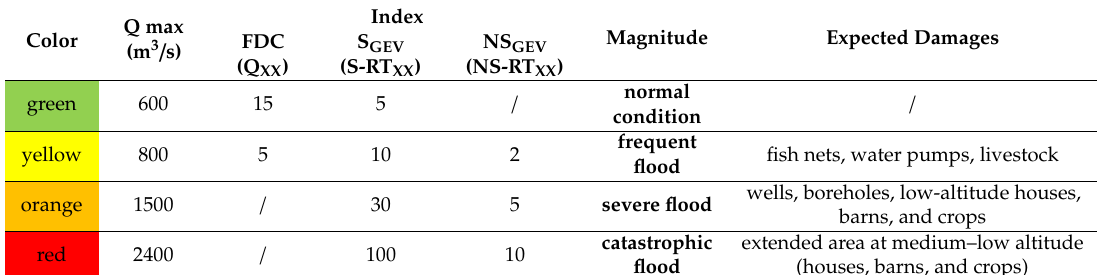
Table 5. Hazard thresholds for the di ff erent flow conditions of the Sirba